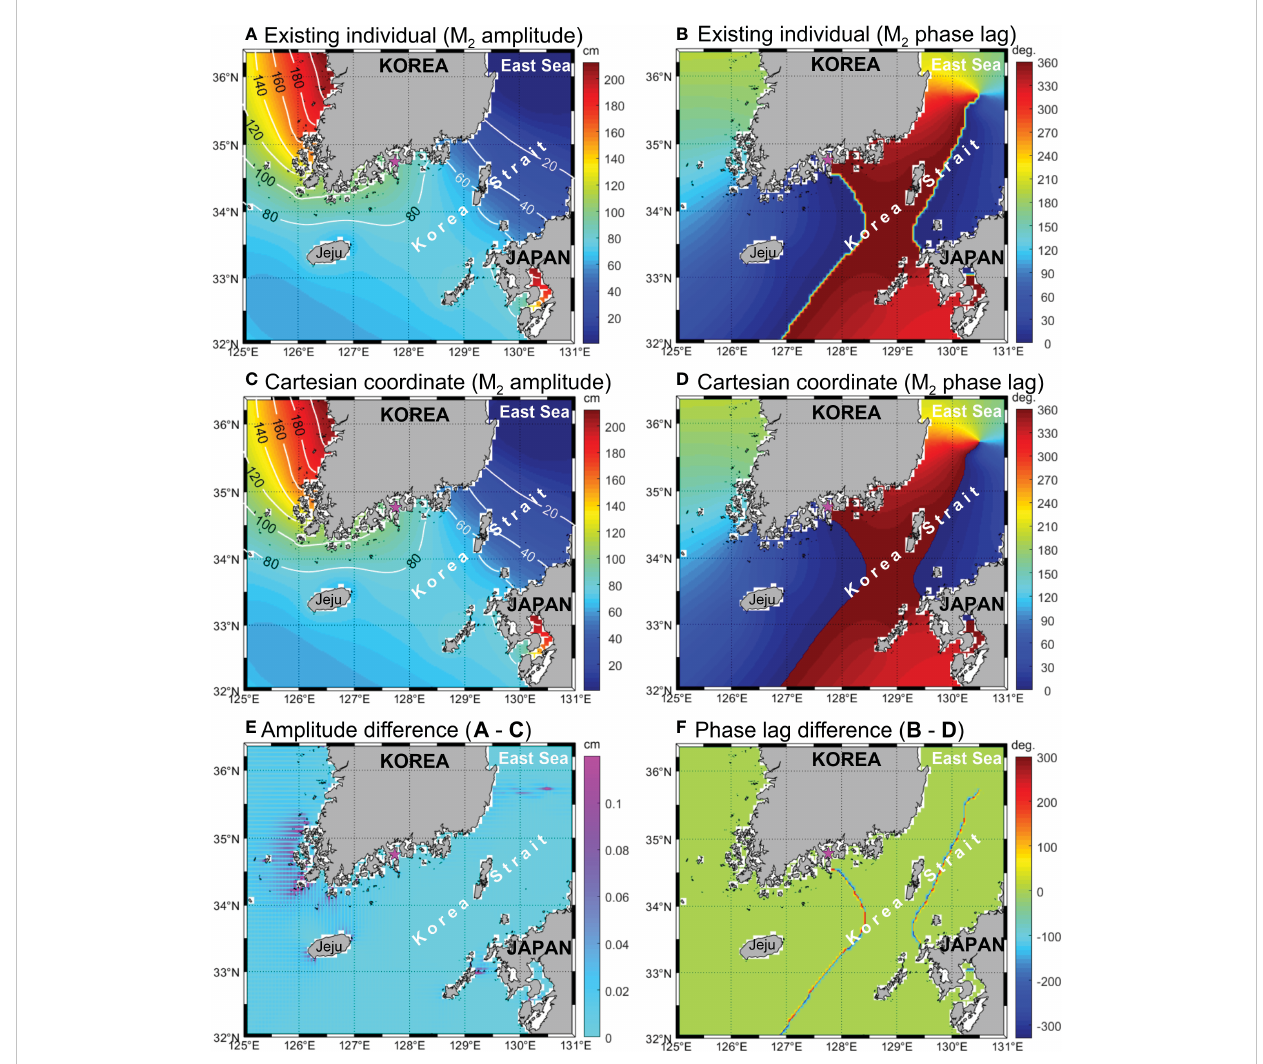
FIGURE 1 M 2 co-amplitude and cotidal charts (A – D) around Korea Strait produced using the existing individual linear interpolation method (A, B) and the Cartesian coordinate based linear interpolation method (C, D) with FES2014 tidal constant data (horizontal resolution of 1/16°). Plots (E, F) of the differences between the two interpolated charts (i.e., (A − C) , and (B − D) are shown to highlight the errors introduced using the existing linear interpolation method (E, F) . Phase lags are referenced to Greenwich. The magenta star indicates the location of Yeosu Tidal Station, which is operated by